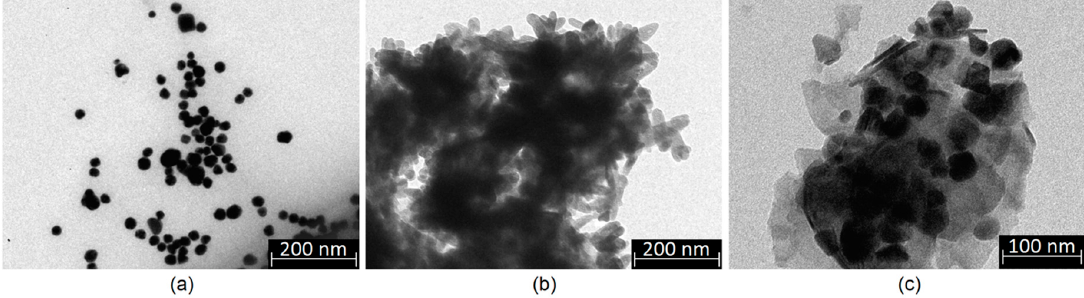
Figure 2. TEM images of the prepared nanoparticles: ( a )—Au nanoparticles; ( b )—Fe 3 O 4 nanoparticles; ( c )—ZnO nanoparticles.